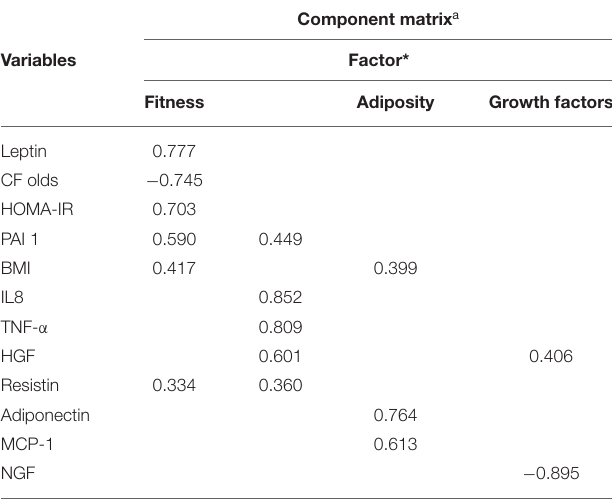
TABLE 2 | Principal component analysis for the study extracted from fitness, body composition, insulin resistance, adipokines, and inflammatory biomarkers